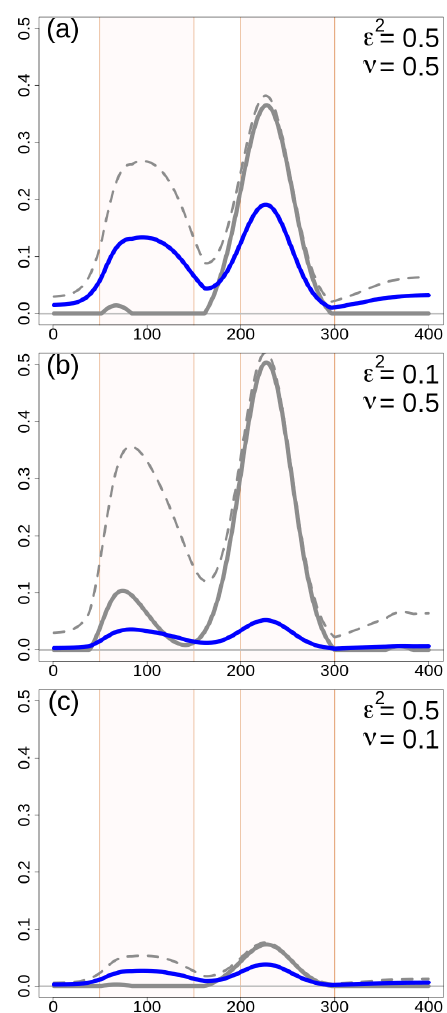
Figure 2. One-dimensional simulation. Error variances (dimension- less quantities) for different configurations of the scaling parame- i i σ 2 u (thick gray line), σ 2 ters. The variances shown are (dashed gray b i i i i σ 2 o ( = ε 2 σ 2 ) (blue line). σ 2 σ 2 line), and is the difference between b f b i i σ 2 u . For all panels, L = 25u in (cid:48) and the error variances do and i i (cid:48) or (cid:48) u . (a) ε 2 = 0 . 5 and ν = 0 . 5. (b) not depend on choices on ε 2 = 0 . 1 and ν = 0 . 5. (c) ε 2 = 0 . 5 and ν = 0 . 1. The two regions, R1 and R2, have been highlighted with different shading in the back- ground of each